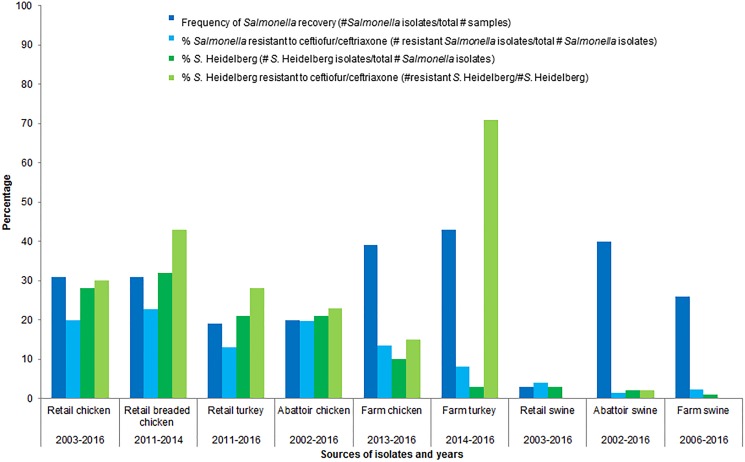
Percentages of isolates recovered and percentages of Salmonella spp. and S. Heidelberg isolates resistant to ceftiofur/ceftriaxone, by food animal species.